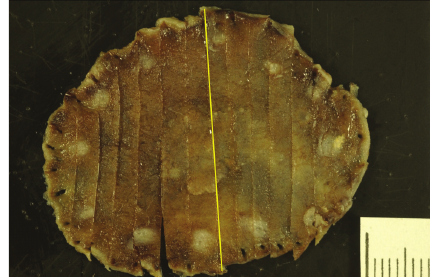
F 3: Resected specimen aer endoscopic submucosal dissec- tion.